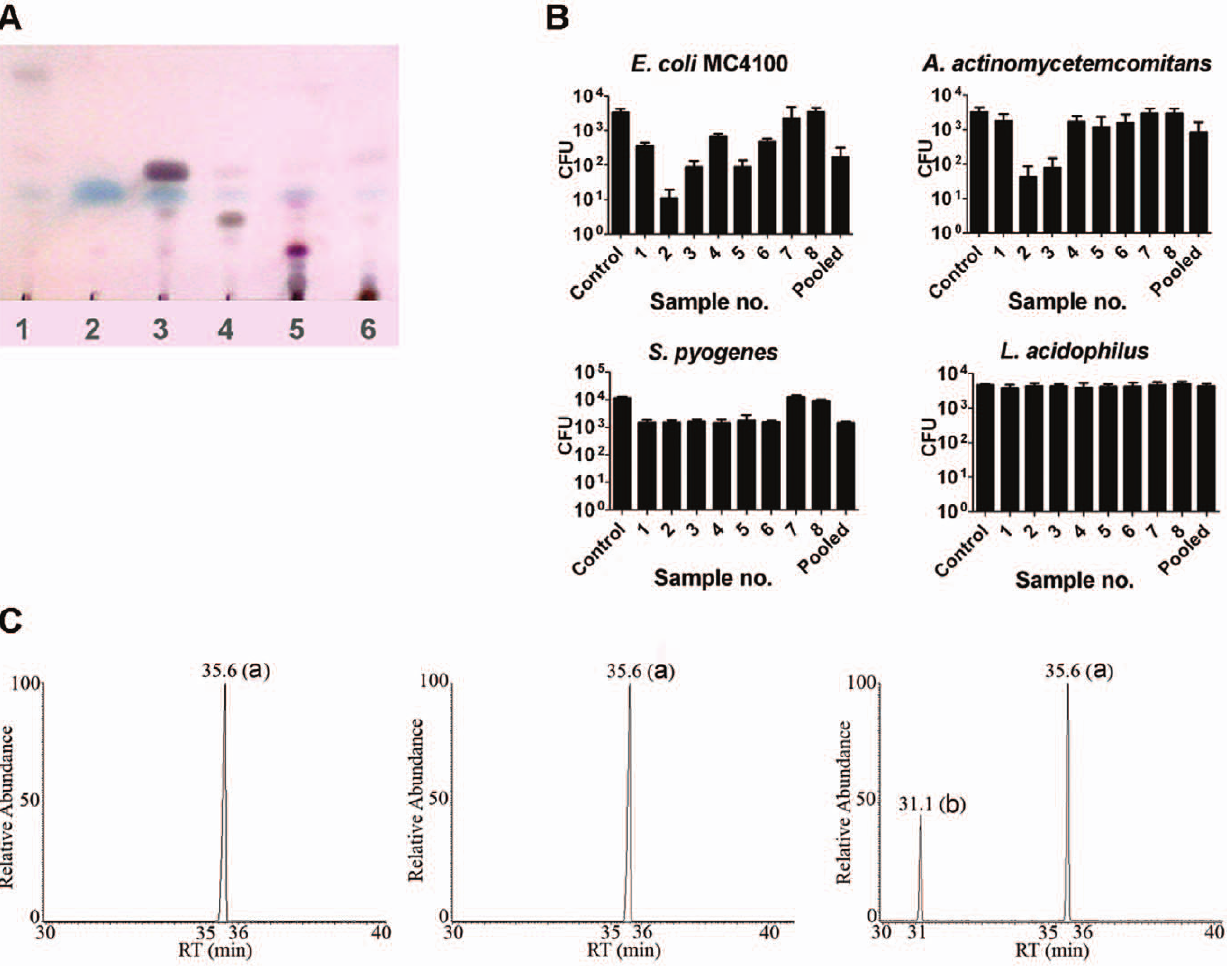
Figure 4. Analysis of Spersica root components by thin layer chromatography, antibacterial activity and GC-MS. (A) TLC analysis of MPLC extracted-fractionated samples 1–6. Samples 7 and 8 are not shown since their components were too hydrophilic to be mobile in the ethyl acetate-hexane solvent. (B) Antibacterial activity of MPLC samples against two Gram-negative and two Gram-positive bacteria. The individual bars show the statistical mean and standard deviation of the number of surviving bacteria from two experiments. Pooled, denotes samples 1–8 mixed together. Control is with DMSO only. (C) Chromatogram of MPLC-samples with antibacterial activity. Sample 2 (left) and sample 3 (middle) displayed one major compound (a)=benzyl isothiocyanate. Sample 5 (right) displayed both compound (a) and compound (b)=Benzyl nitrile.